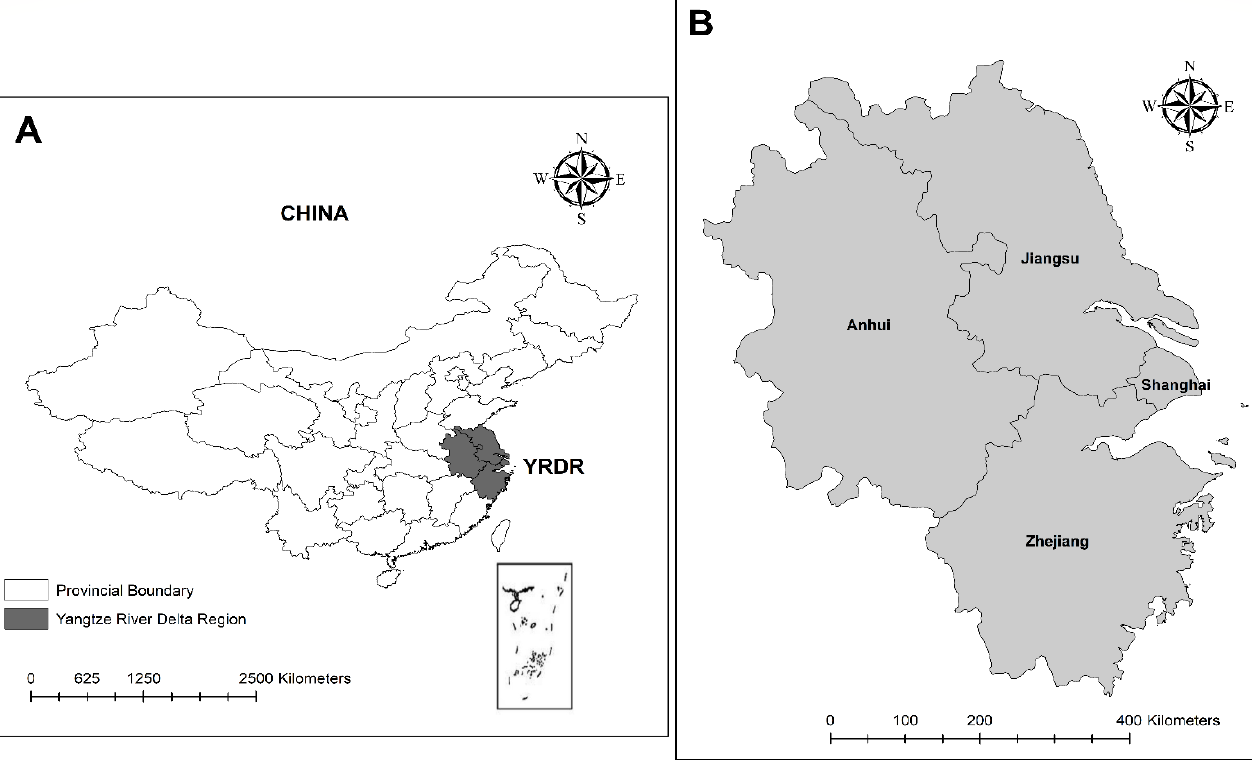
Figure 1. The provincial administrative boundaries of: ( A ) China and ( B ) Yangtze River Delta region.